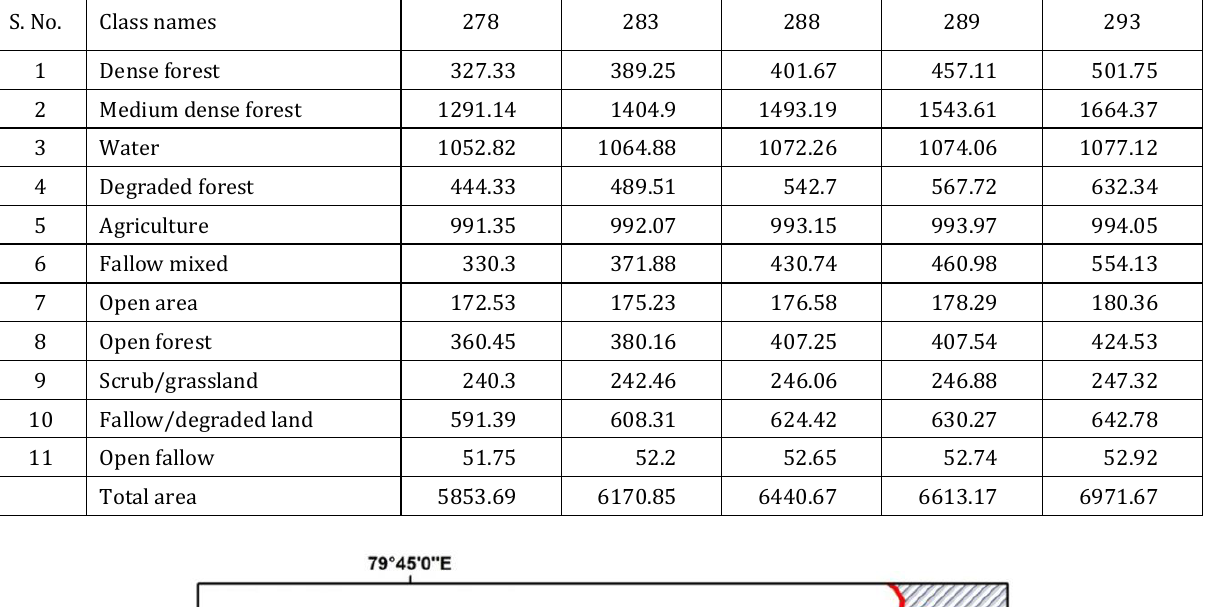
Table 5. LULC of submergence area (in ha) in Panna Tiger Reserve (PTR) at various FRL (m) S. No.